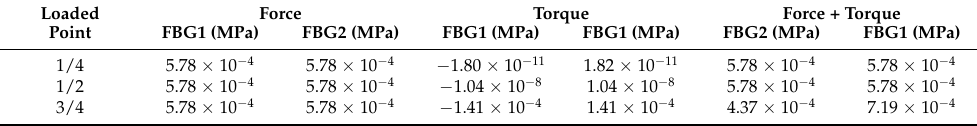
Table 5. Absolute value of the maximum equivalent stress.